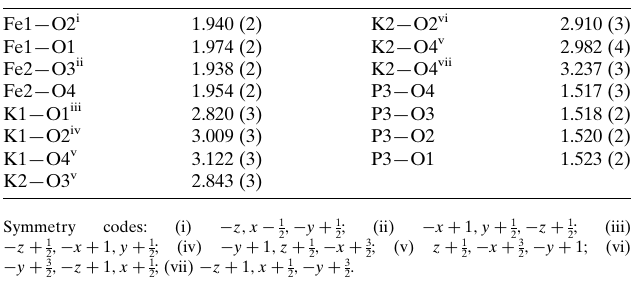
Table 2 Selected bond lengths (A˚ ) for